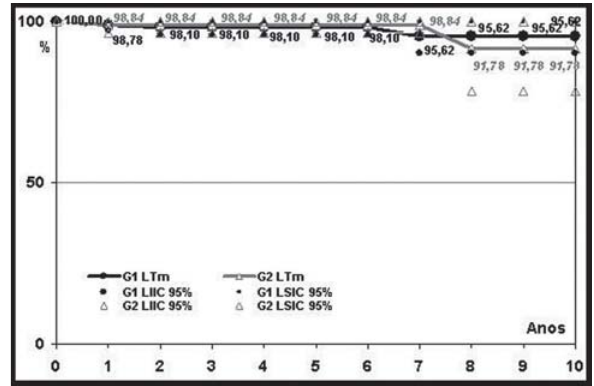
Fig. 5 - Curvas atuariais e pontos de limites superior e inferior do intervalo de confiança de 95%, de acordo com os conjuntos de grupos (G1 e G2) Livres de eventos tromboembólicos menores – LTm;Limite inferior do intervalo de confiança 95% - LIIC 95%; Limite superior do intervalo de confiança 95% - LSIC 95%. Os números próximos aos pontos de inflexão das curvas são referentes